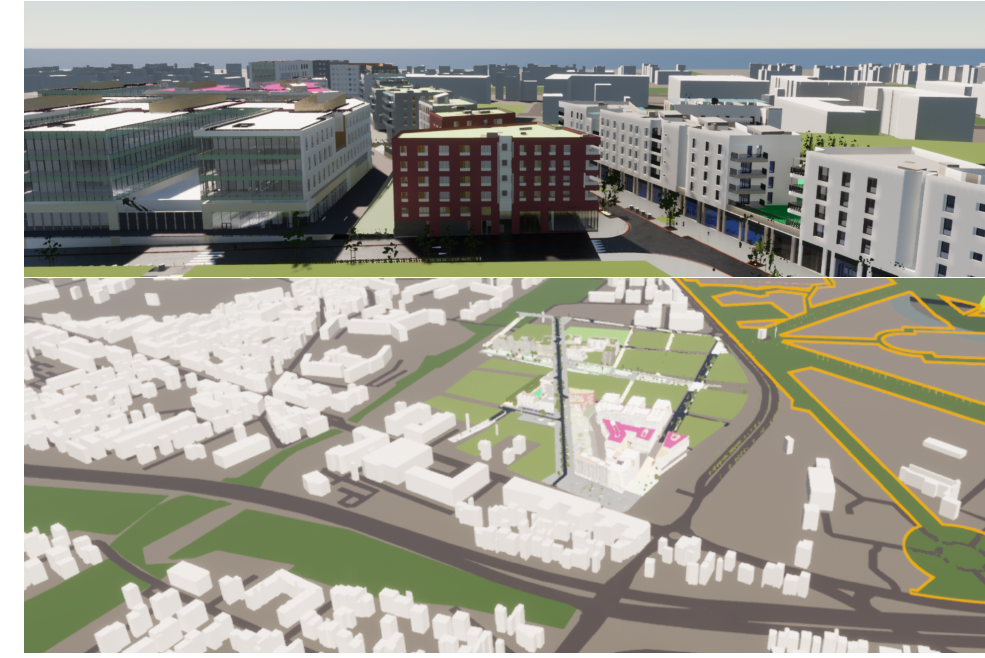
Figure 11. LaVallée model with urban context from